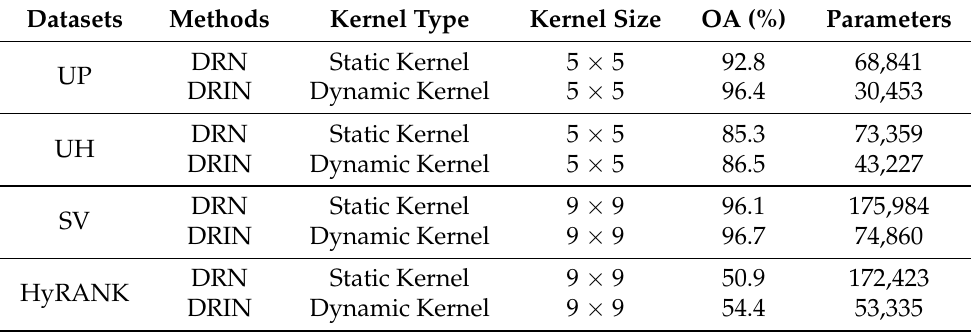
Table 18. Comparison between the proposed DRIN and the baseline model DRN when using the same kernel size at all bottleneck positions.